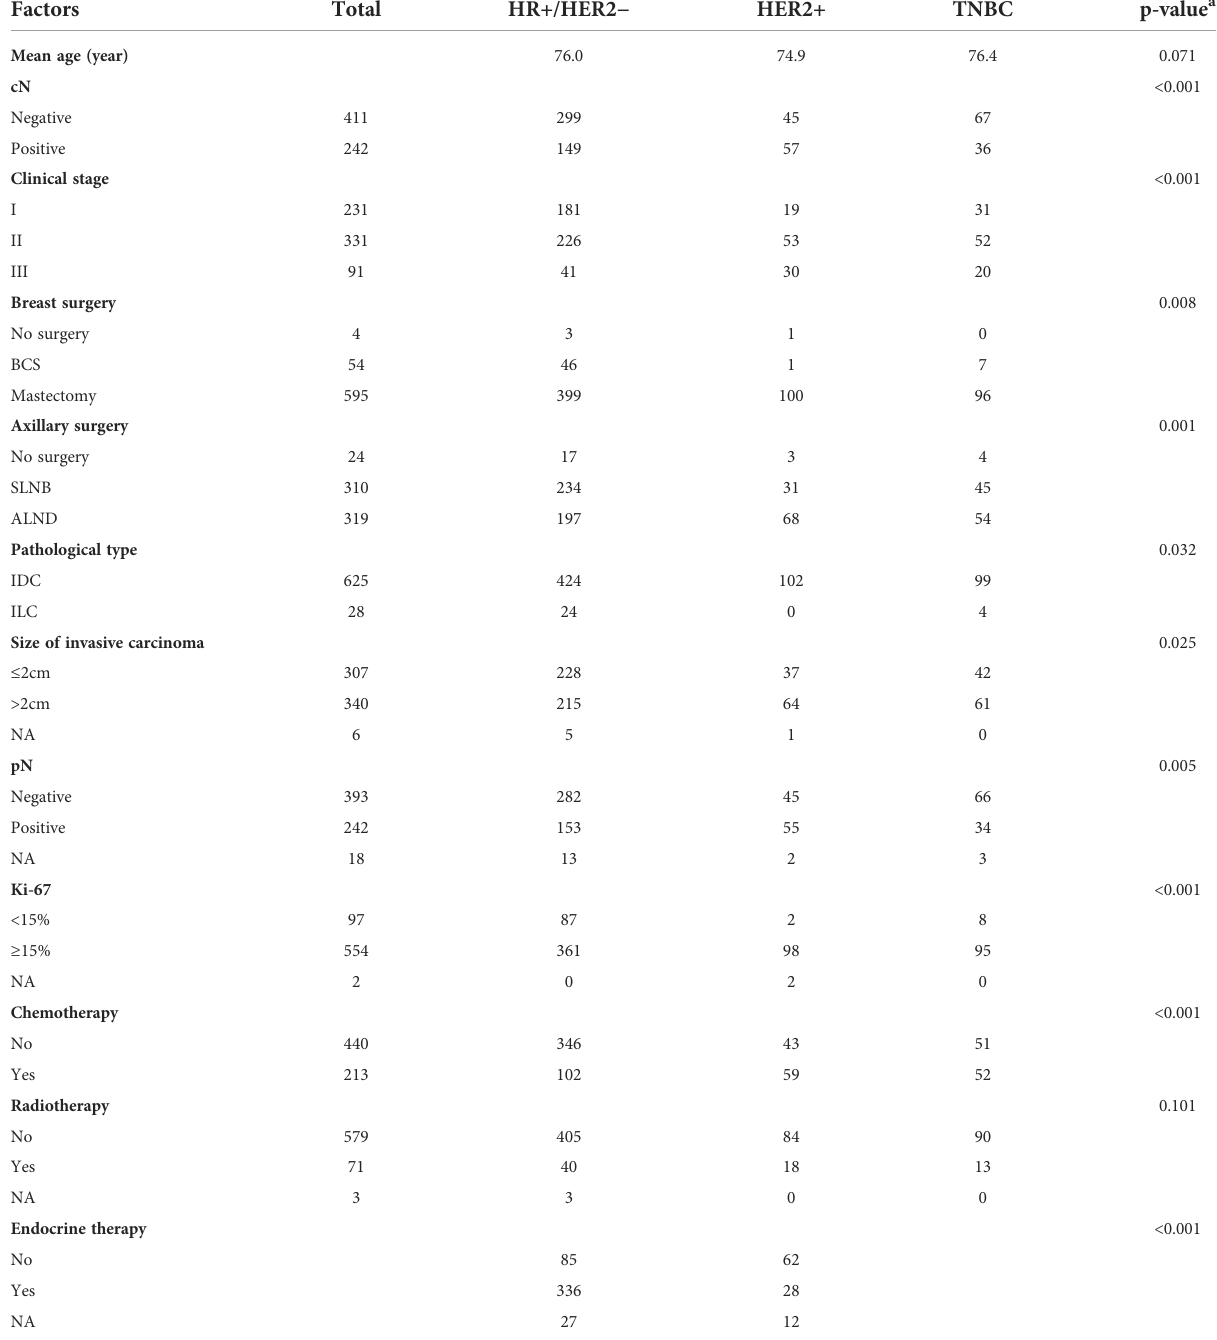
TABLE 1 Clinicopathological characteristics of enrolled cases according to molecular